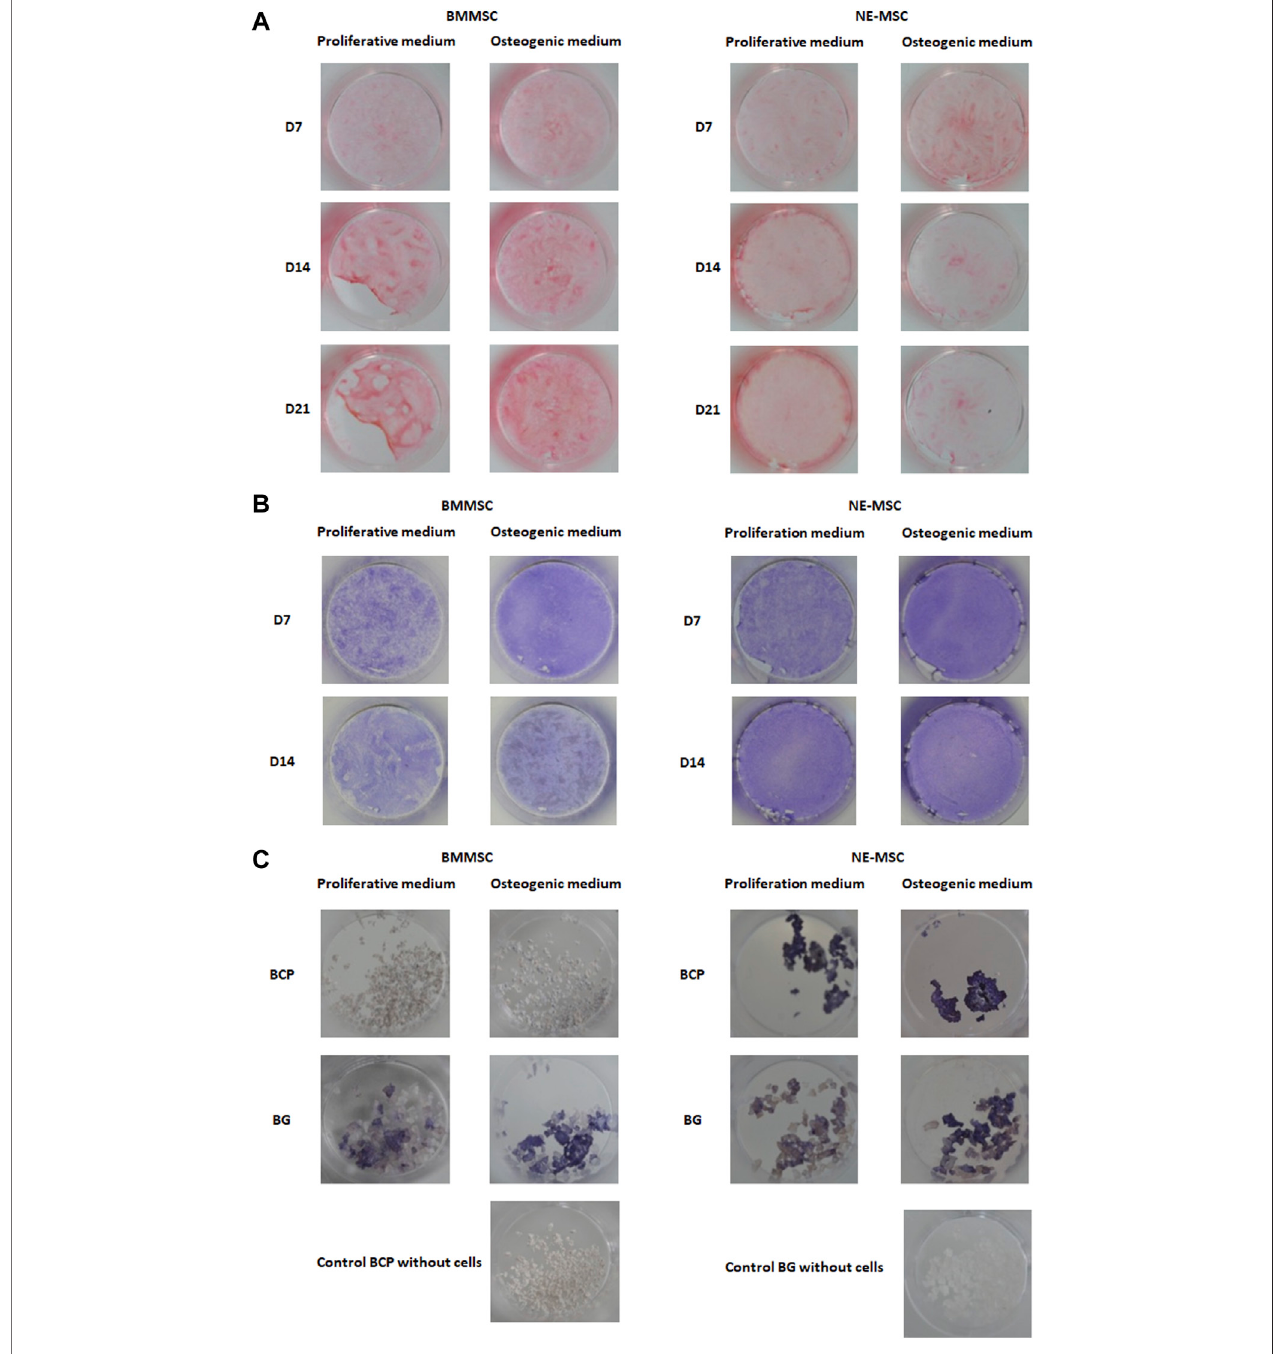
FIGURE 5 | (A) Comparative production of collagen. In osteogenic conditions, BMMSCs increasingly produce collagen while the opposite is observed for NE- MSCs.ComparativeproductionofALPbybothcelltypes,atD7.BMMSCsandNE-MSCswerecultivatedeitheronplastic (B) orbiomaterials (C) .BMMSCsexpressALP only when cultivated on BG biomaterial while NE-MSCs produce ALP on both biomaterials. For NE-MSCs, ALP production is higher in proliferative medium.